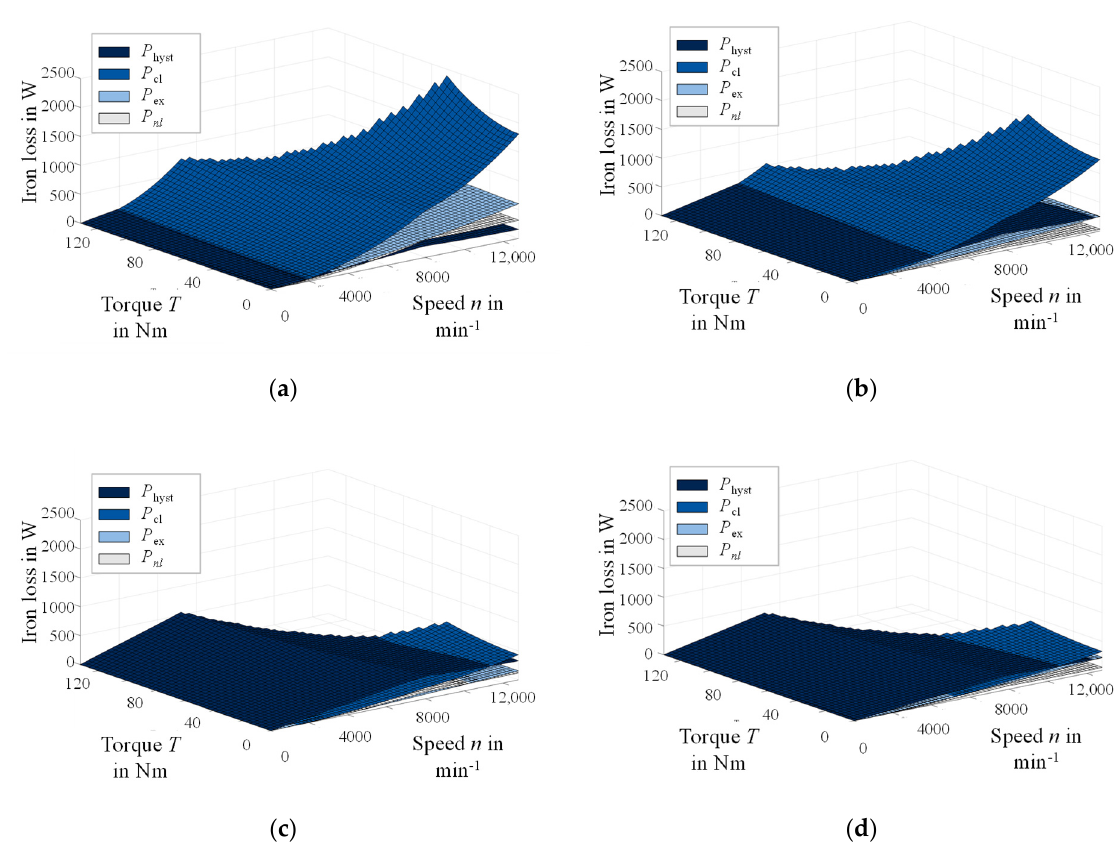
Figure 12. Simulation study results of stator loss in a torque-speed map: ( a ) 1b—Fe–2.4 wt % Si, 0.5 mm, 265 µm; ( b ) 2g— Fe–3.2 wt % Si, 0.5 mm, 43 µm; ( c ) 1d—Fe–2.4 wt % Si, 0.25 mm, 37 µm; ( d ) 2k—Fe–3.2 wt % Si, 0.25 mm, 162 µm.